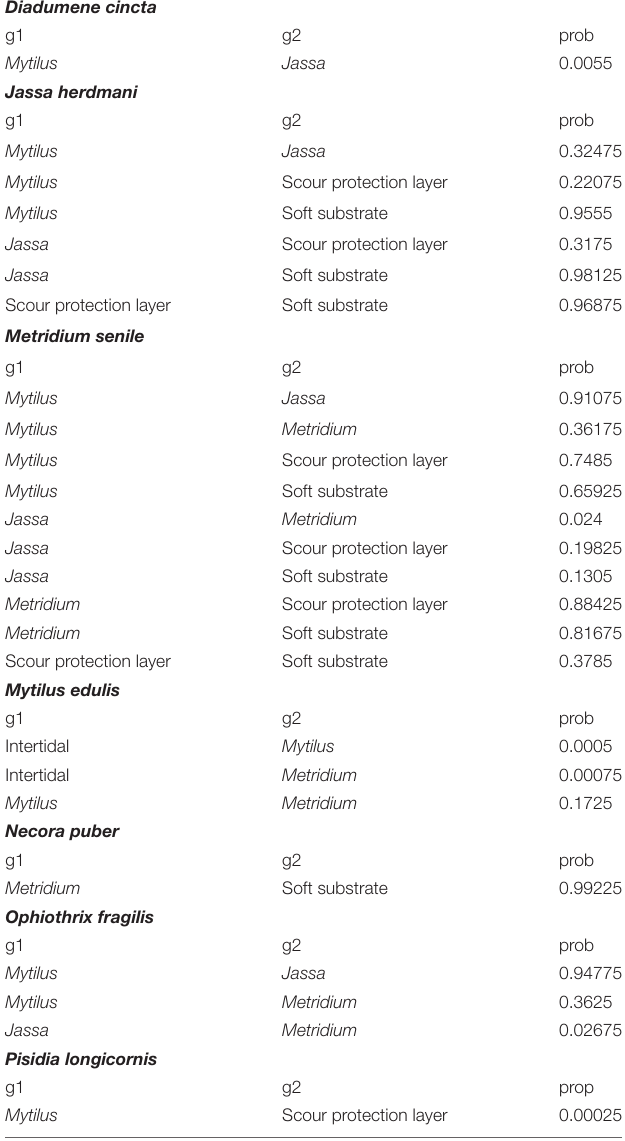
TABLE 3 | Bayesian standard ellipse area (SEA B ) probabilities (prob) that the ellipse area of one group (g1) is smaller than the other (g2). Diadumene